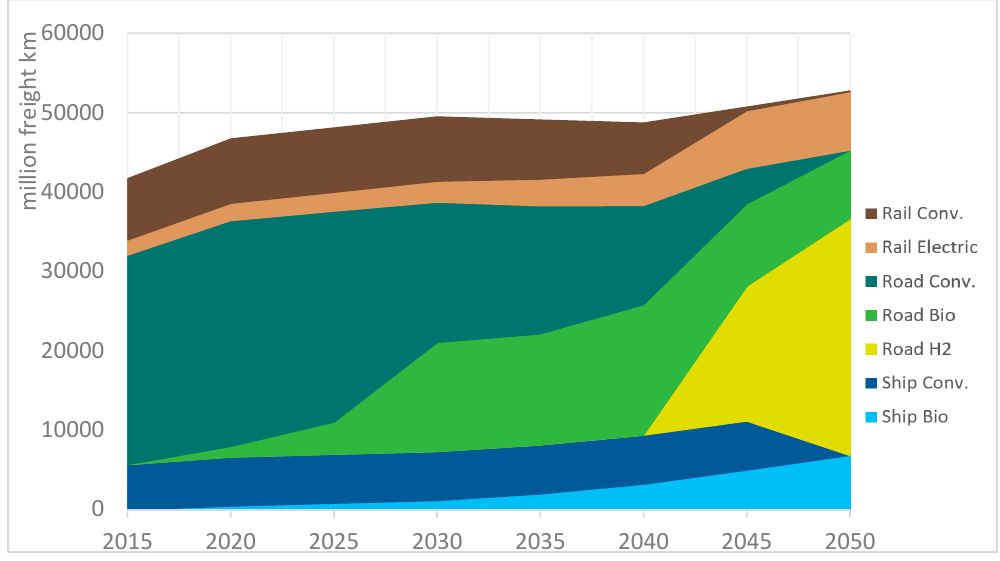
Figure 9. Development of freight transportation services.